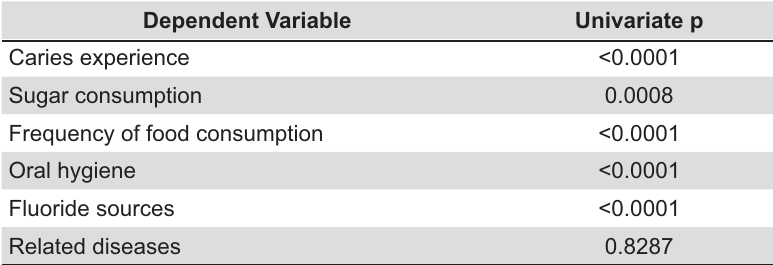
Table 3- Variables included in the univariated